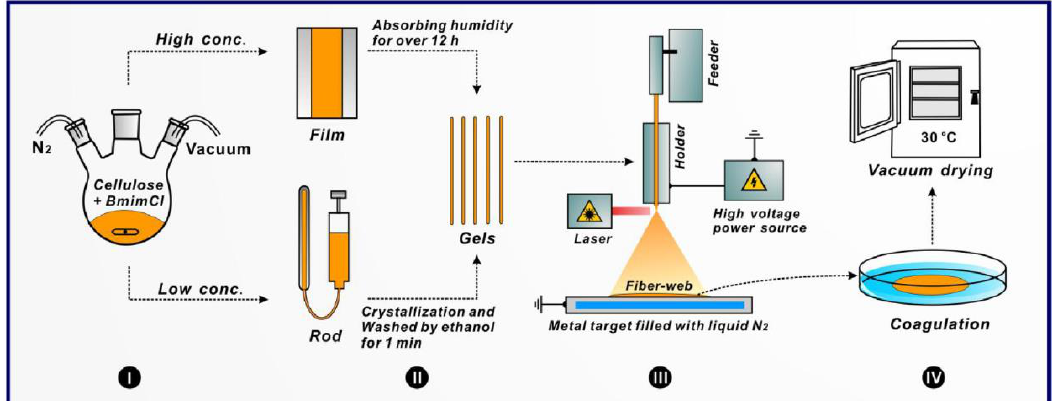
Figure 6. Preparation steps for cellulose fibers: (I) Dissolution, cellulose and BmimCl were mixed in the presence of nitrogen for 2 h to form a homogeneous solution; ( II) gels rods preparation, high and low concentration of cellulose were prepared using film casting and crystallization, respectively to be fed by a holder; (III) melt-laser electrospinning setup, fabricating viscous polymer and collecting freeze fiber at − 40 °C; (IV) fibers coagulation, fibers were washed in ethanol bath then dried under vacuum [65].